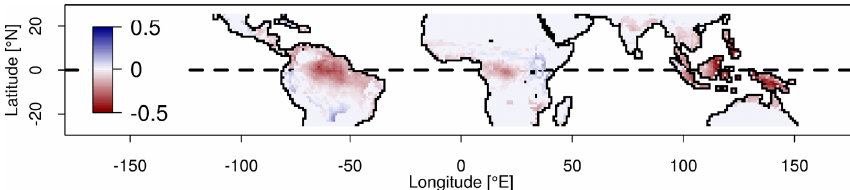
Figure 9. Pearson correlation coefficient between bias-corrected GLDAS soil moisture and the Niño-3.4 index from 1979 to 2016. Colors indicate regions where the mean correlation was negative (red) and positive